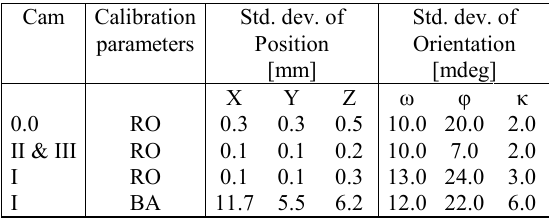
Table 1. Calibration accuracy of relative orientation (RO) as well as boresight alignment (BA) parameters